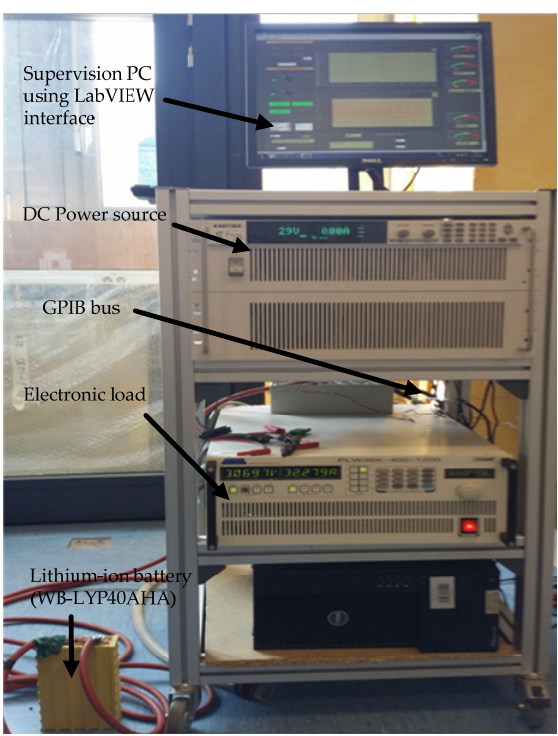
Figure 3. Battery test bench architecture. Table 1. Specifications of the batteries.